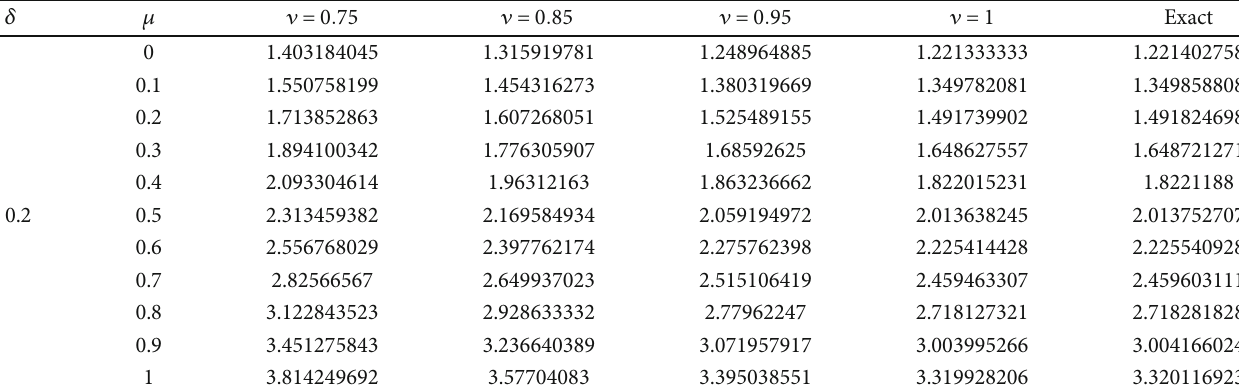
Table 2: Solution for the fi rst three approximations with exact solution, with mesh points δ = 0 : 2 , for equation